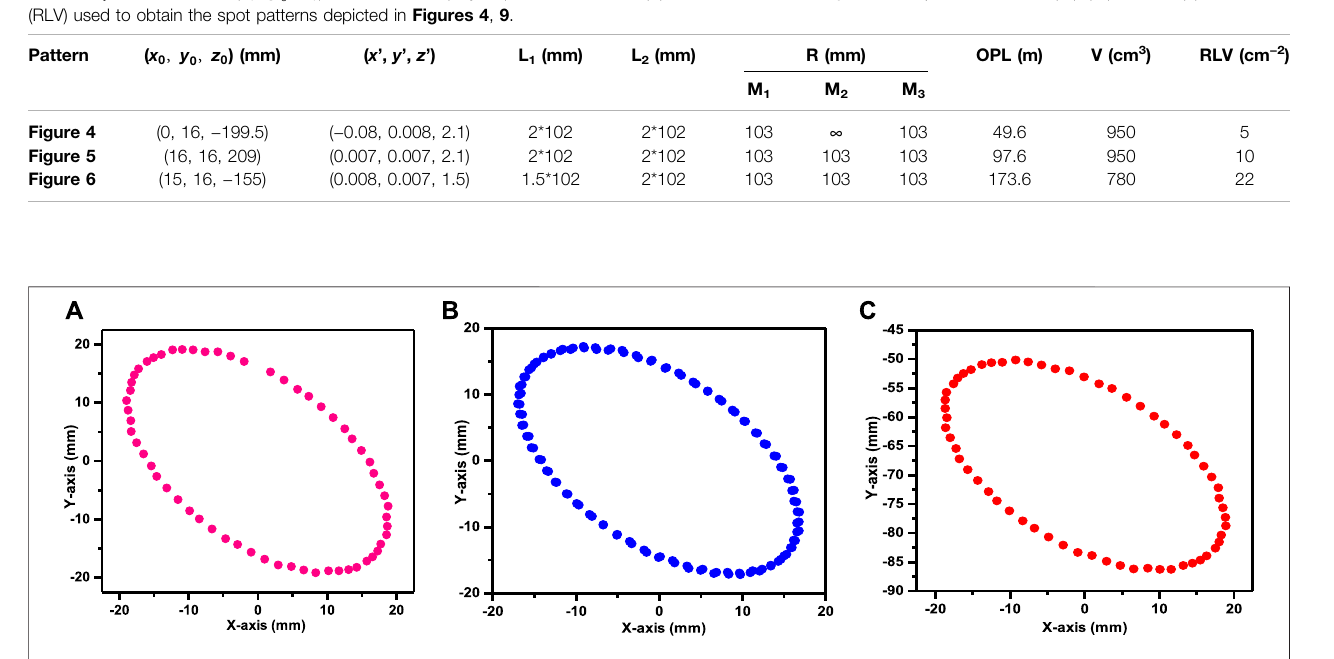
FIGURE 4 | Spot patterns simulated by optical software, (A – C) Spot patterns on spherical mirrors M 1 , M 2 , and M 3 of three different MPCs, respectively. The initial ray parameters for the spot pattern are listed in Table 1 . Pass counts n = 61 times.